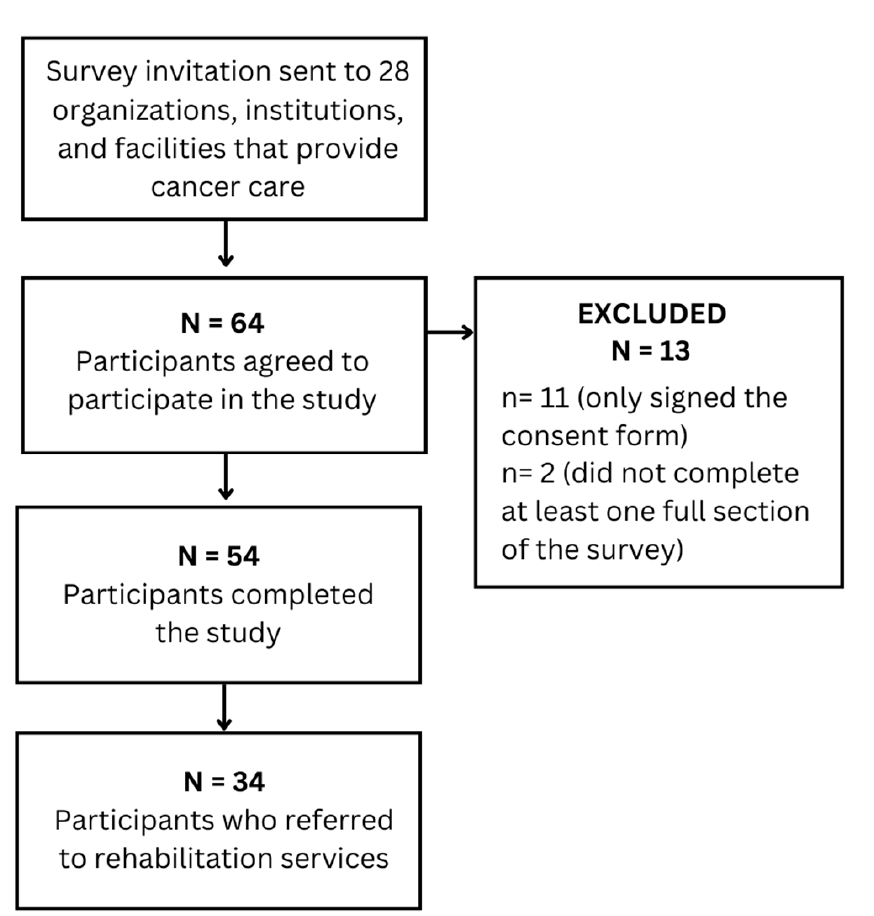
Figure 1. Flow diagram of survey respondents.